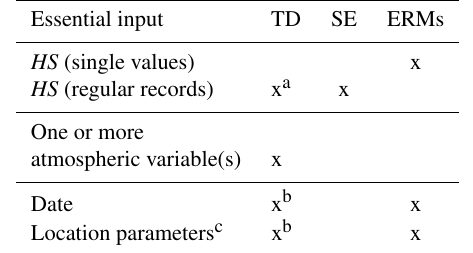
Table 1. Different types of SWE models, categorized by their essen- tial input. TD, SE, and ERMs are abbreviations for thermodynamic, semiempirical, and empirical regression models,